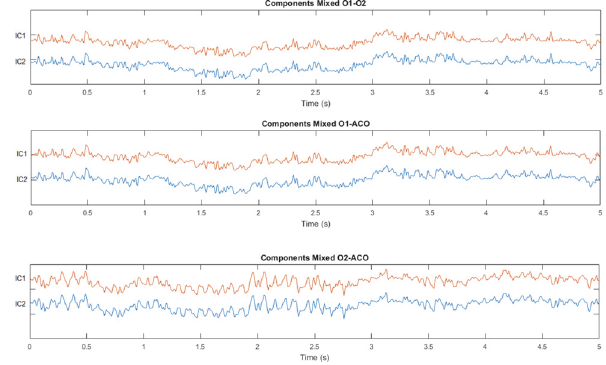
Figure 24: ICA independents components.